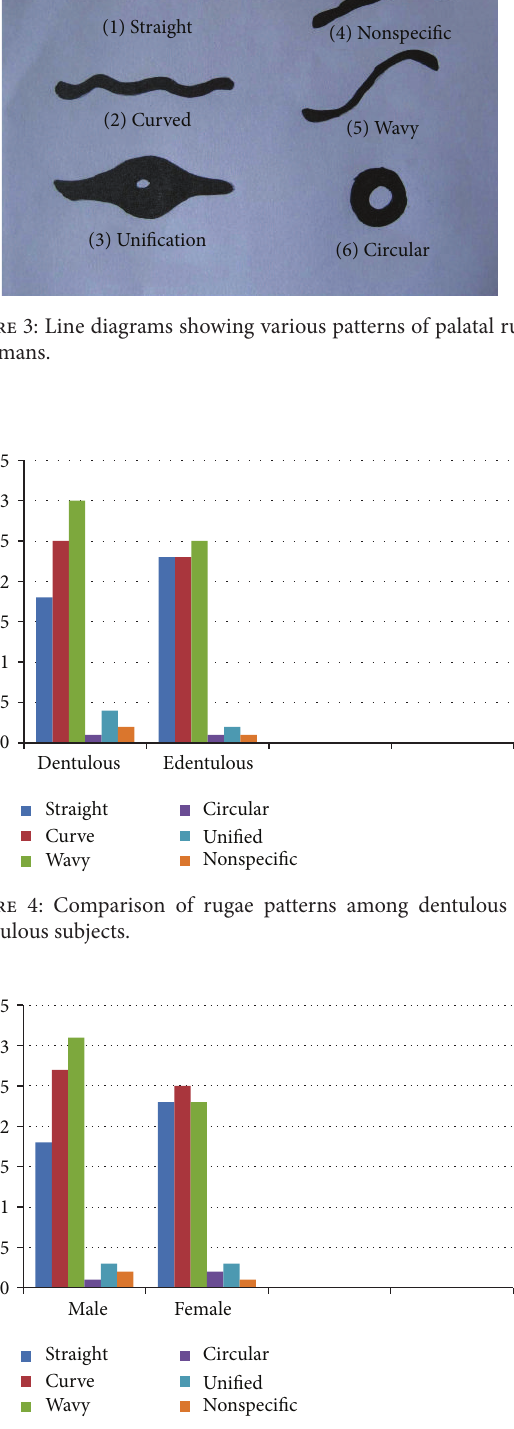
Figure 5: Comparison of rugae patterns among males and